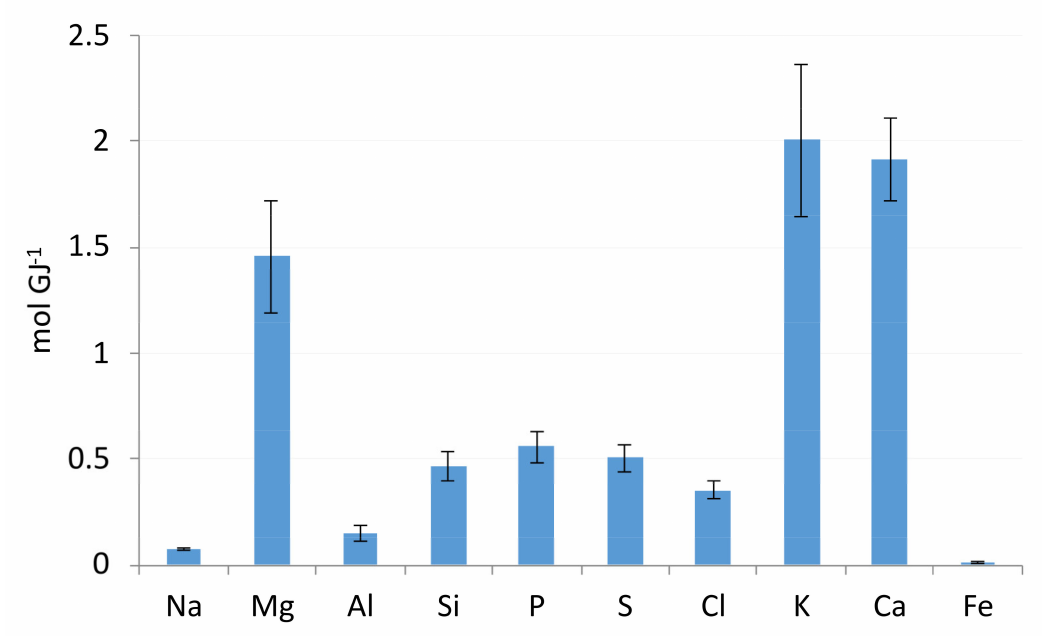
Figure 4. Proportion of main ash-forming elements in the fuel samples and the corresponding standard errors. Amount of ash-forming elements is given on a mole of element per energy unit of fuel dry matter (mol GJ − 1 ) relative to the HHV.